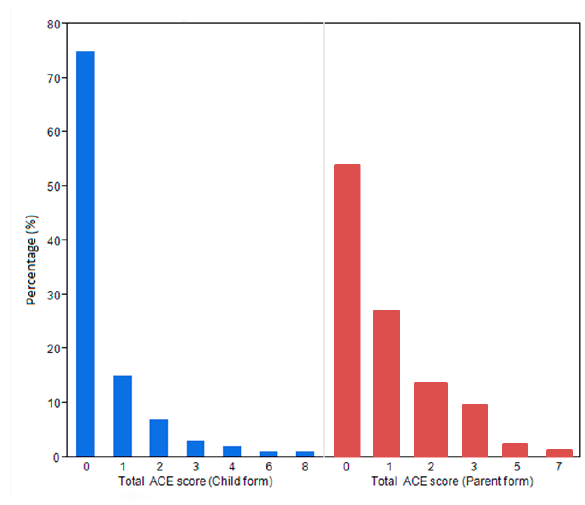
Figure 1. Total adverse childhood experiences (ACE) scores in children and their parents.